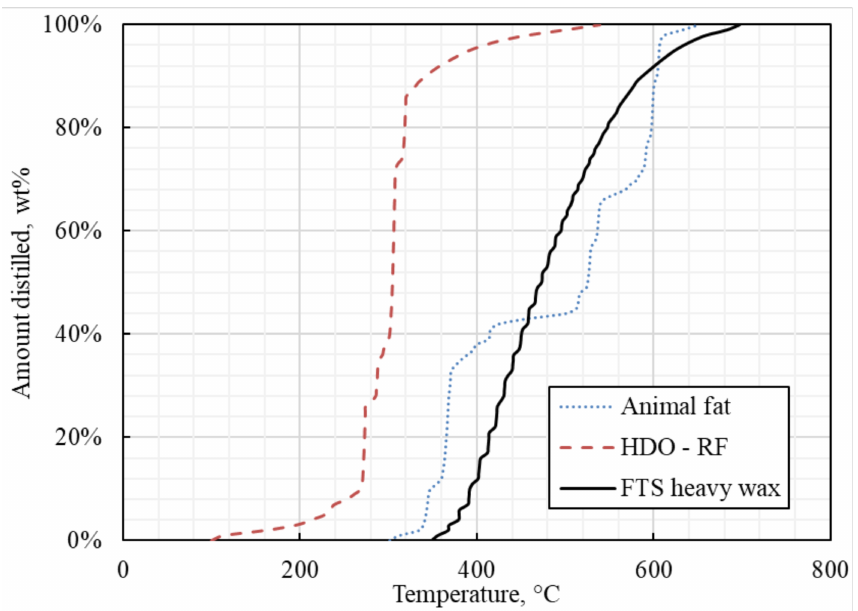
Figure 1. The SIMDIS of the three feedstocks used for the fast pyrolysis tests. The animal fat, the paraffins from the hydrodeoxygenation (HDO) reaction of this animal fat (HDO—RF text in the picture), and the Fischer-Tropsch (FTS) heavy fraction waxes (FTS heavy wax) are displayed in the figure.